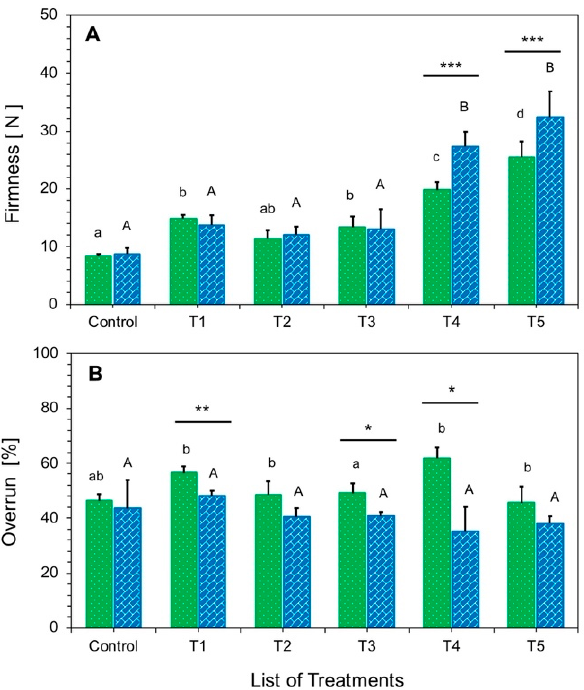
Figure 3. The firmness ( A ) and overrun ( B ) of ice cream treatments with two different process de ‐ signs of PH and HP symbolized by green ( ) and blue ( ) bars, respectively. Different letters (a, b, c, d) for PH and (A, B) for HP on top of the bars indicate significant differences at p < 0.05. The same letter indicates that the products are not significantly different from each other. Error bars indicate standard deviation. See Table 1 for the definition of treatment abbreviations. The signifi ‐ cance levels (* p < 0.05; ** p < 0.01; *** p < 0.001) between process designs.